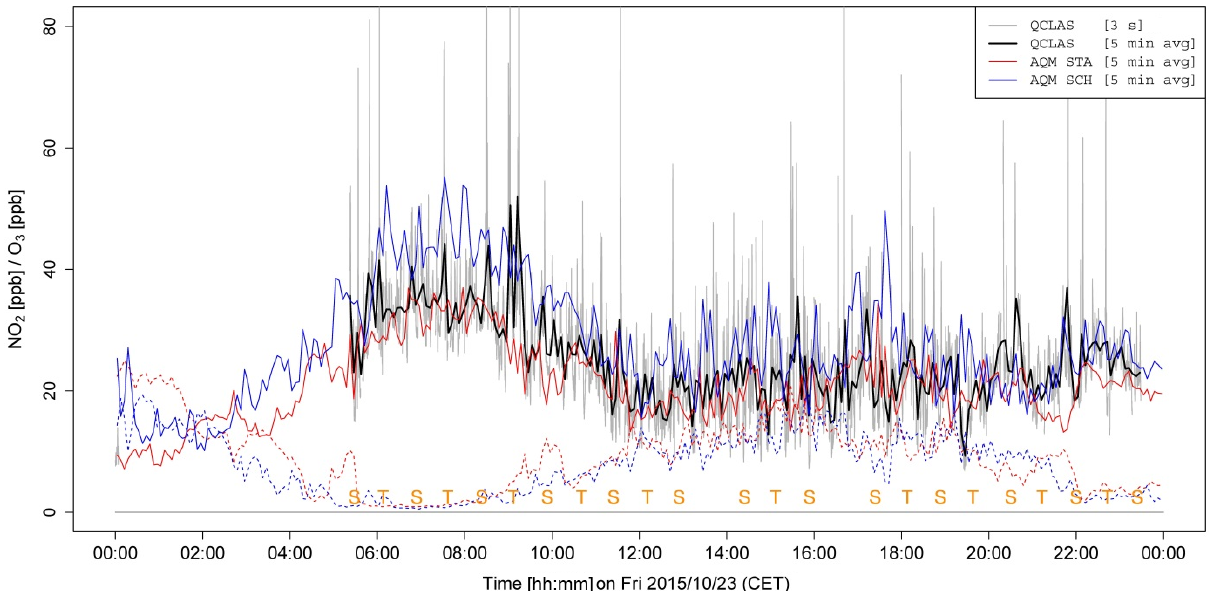
Figure 7. NO 2 time series of the tram based QCLAS (single values and 5min averages) as well as of NO 2 and O 3 measurements from the AQM stations STA and SCH (5min averages). The letters “S” and “T” depict when the tram passes the terminal stations Seebach and